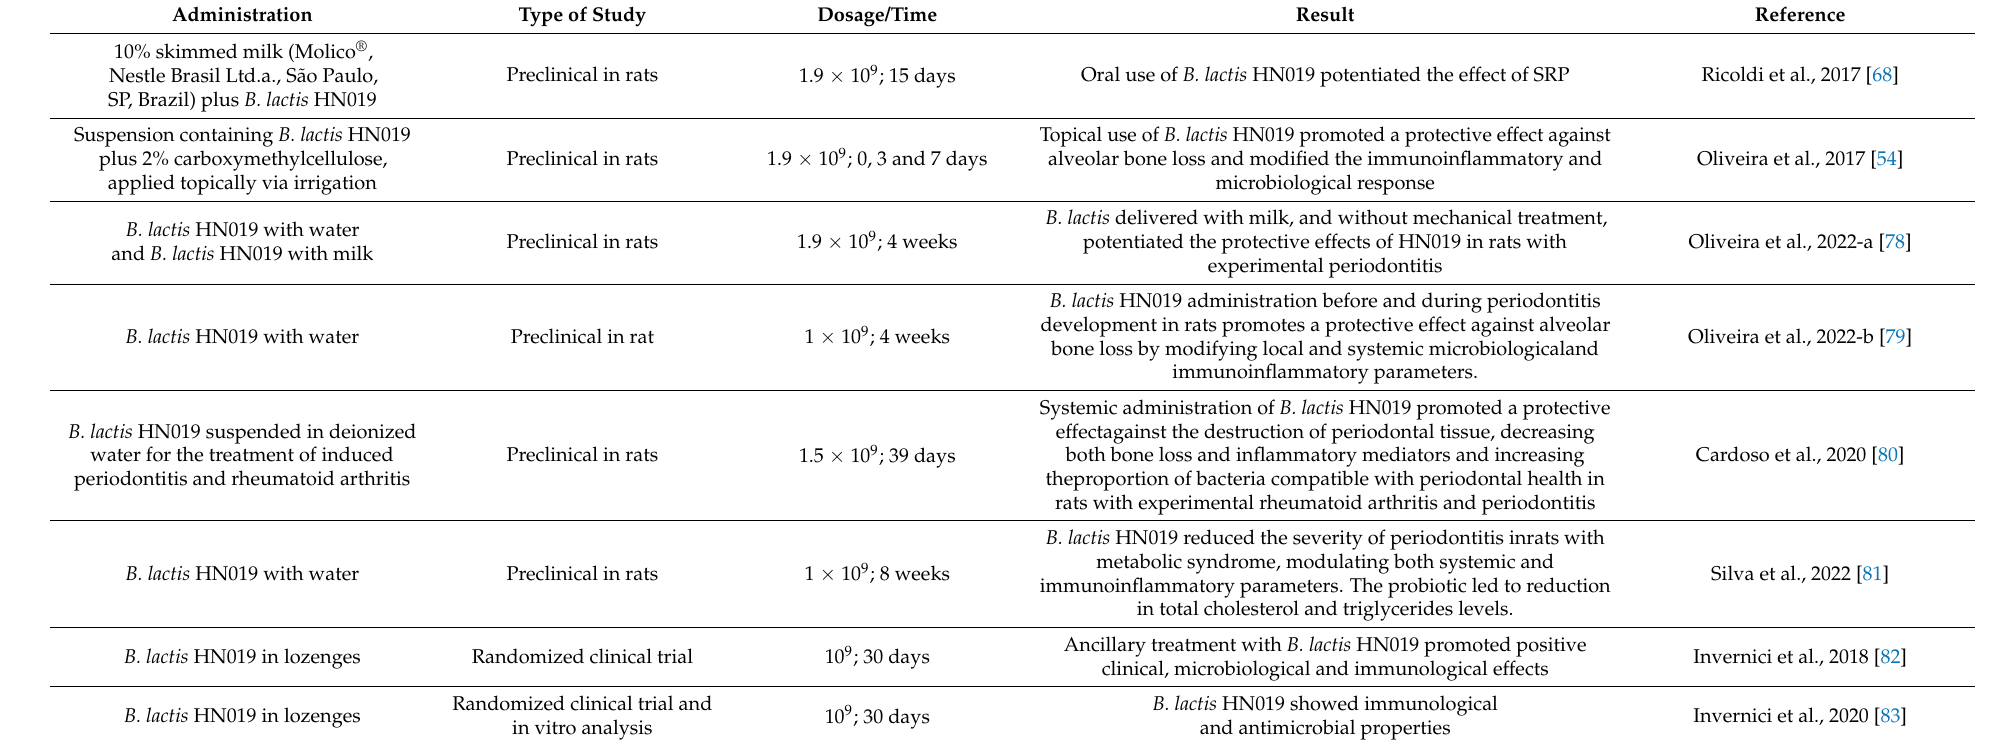
Table 1. Studies using the B. lactis HN019 strain in the context of